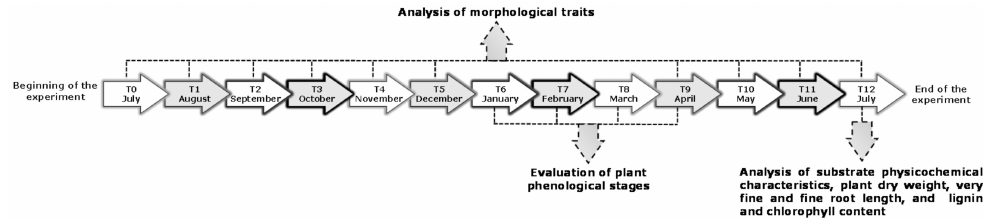
Figure 1. Experimental schedule with the main analyses and the sampling times